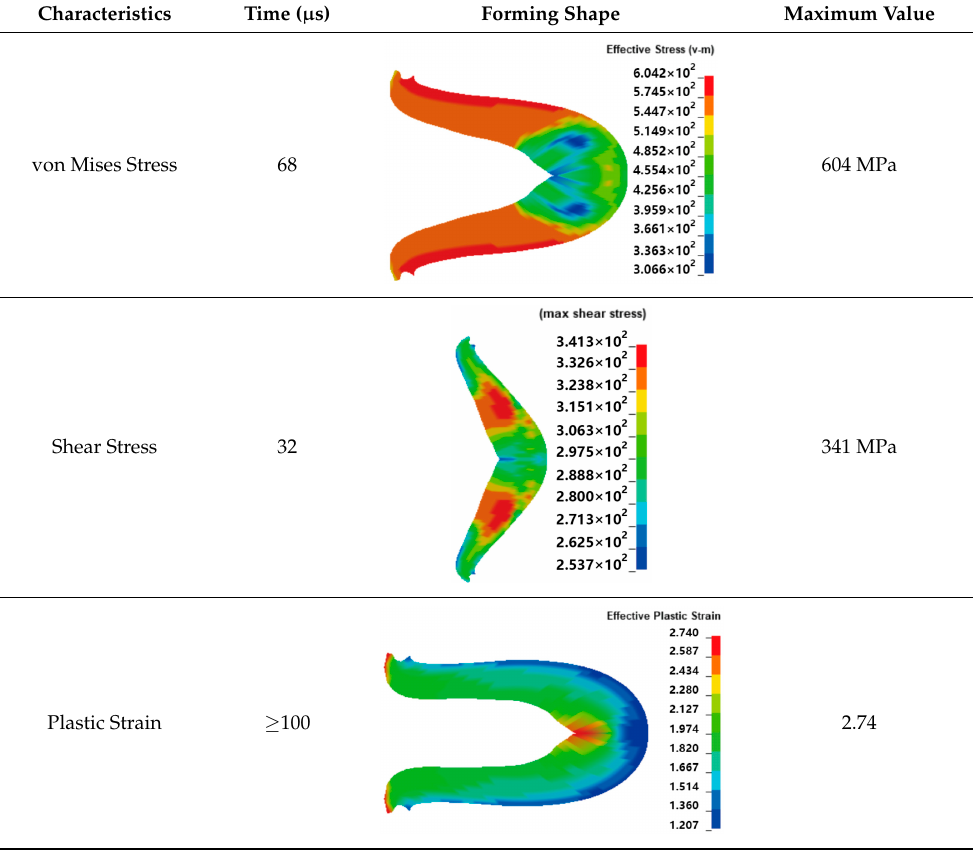
Table 8. Comparison of the copper EFP’s forming states in numerical simulation and the experiment results.